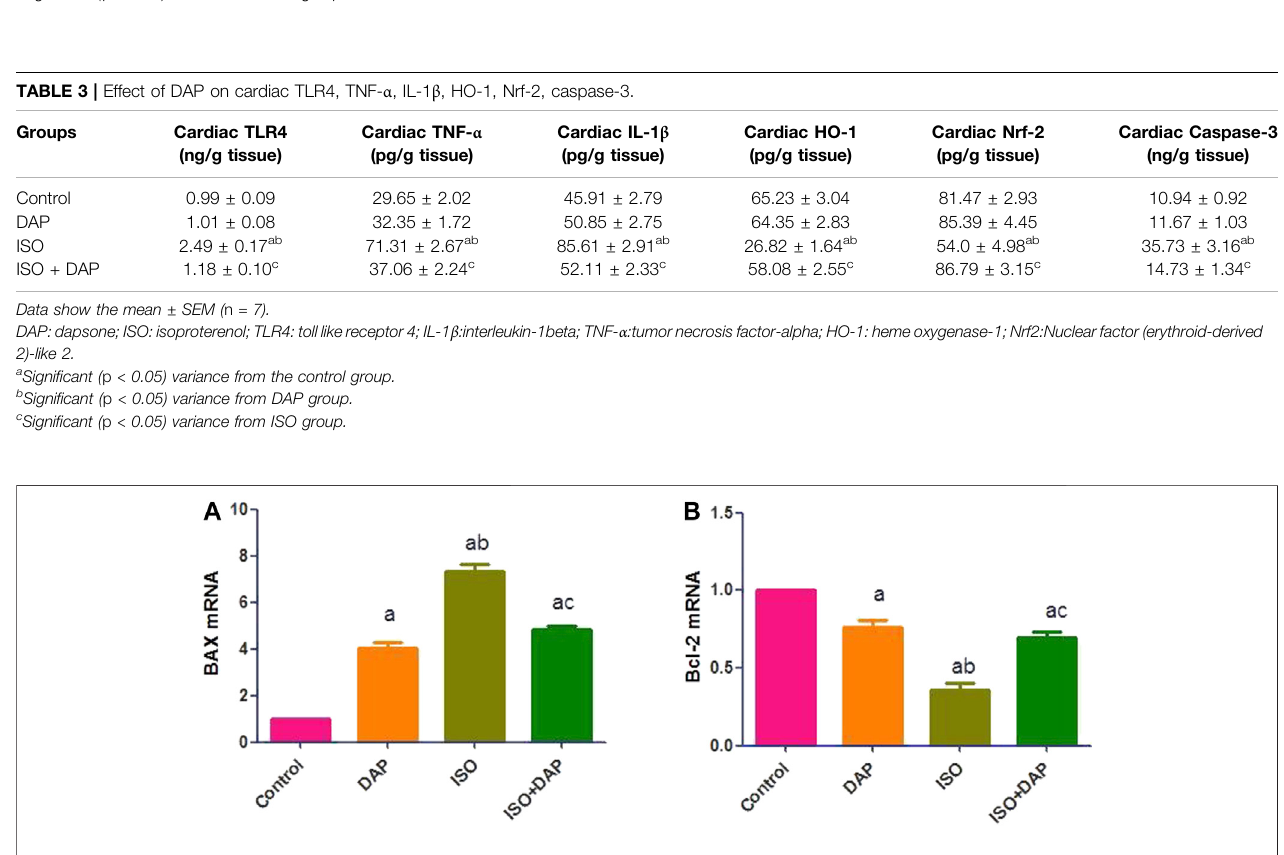
FIGURE2| Effect ofDAPon hepatic BAX (A) and Bcl-2 mRNA (B) inMI inrats. Datashowthe mean ± SEM( n (cid:1) 7). DAP: dapsone; ISO:isoproterenol. a Signi fi cant ( p < 0.05) variance from the control group. b Signi fi cant ( p < 0.05) variance from DAP group. c Signi fi cant ( p < 0.05) variance from ISO group.